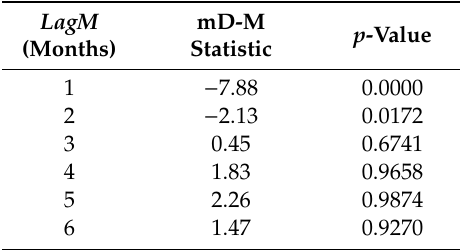
Table 4. Modified Diebold-Mariano test